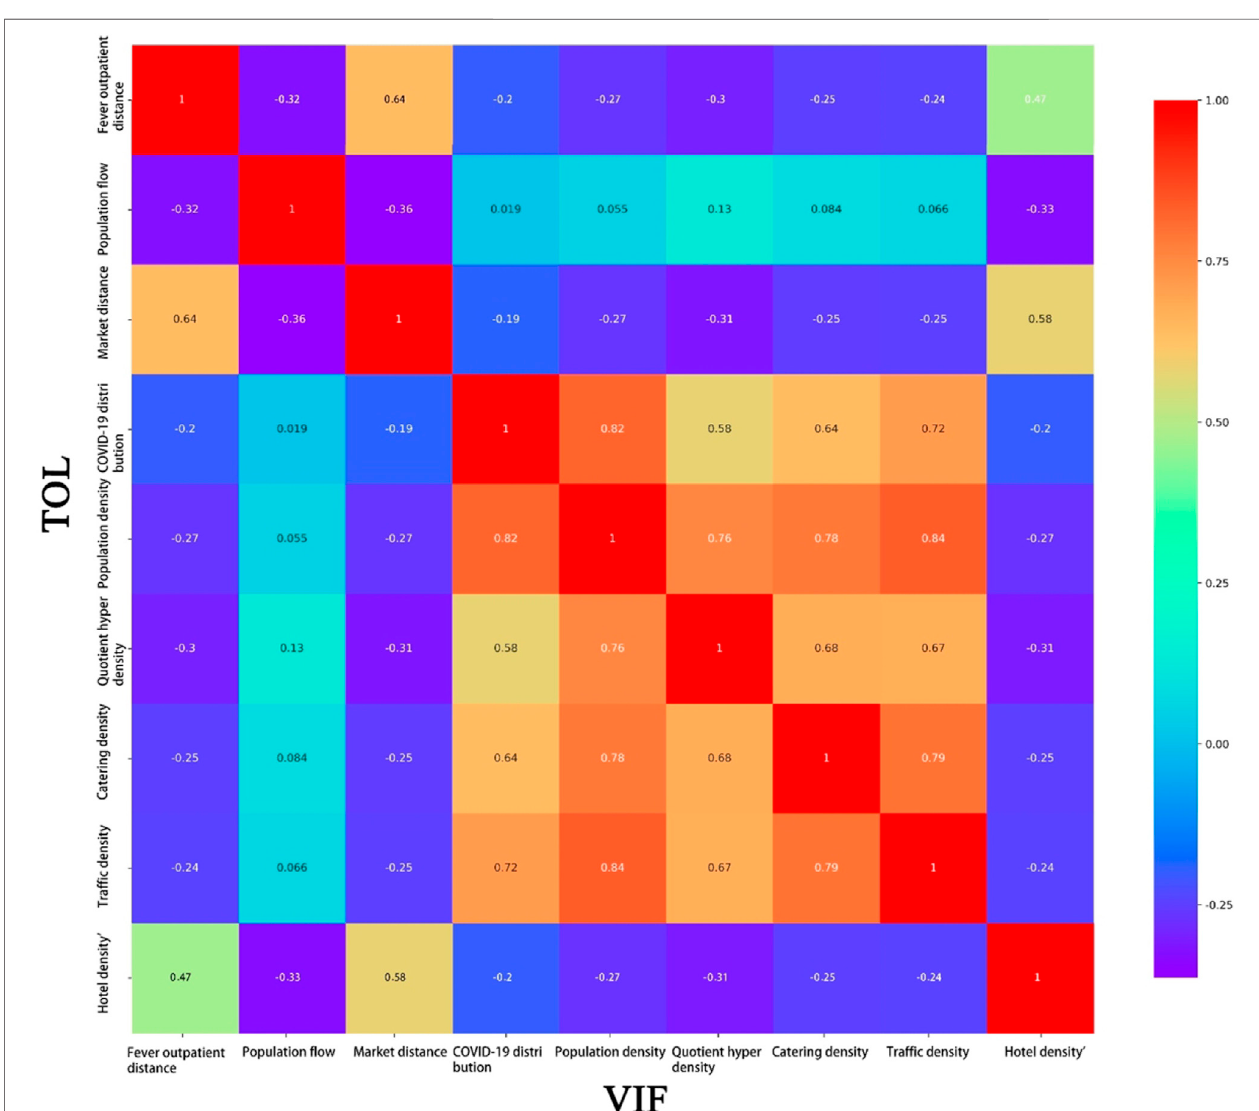
FIGURE6| Heatmapofthecollinearitydiagnosisofin fl uencingfactors(Collinearitydiagnosisofdifferentfactorsisshowninthe fi gure:theTOLofdifferentfactorsis on the left, the VIF of different factors is on the bottom; the value in the fi gure is the product value of TOL and VIF between different factors; the color in the fi gure ranges from blue to red, indicating the corresponding value of TOL and VIF ranges from 0 to 1).